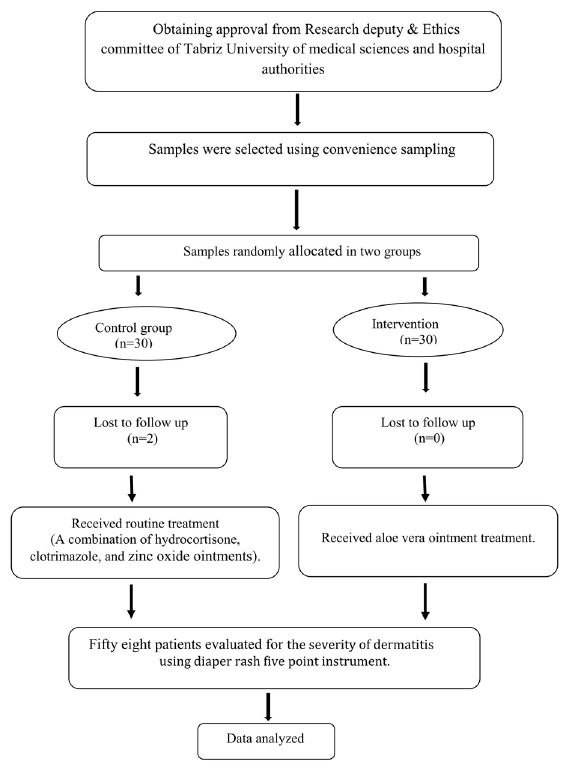
Figure 1. The Flow Diagram of the Study Based on Consort Statement 2012, Indicating Participants’ Recruitment and Intervention